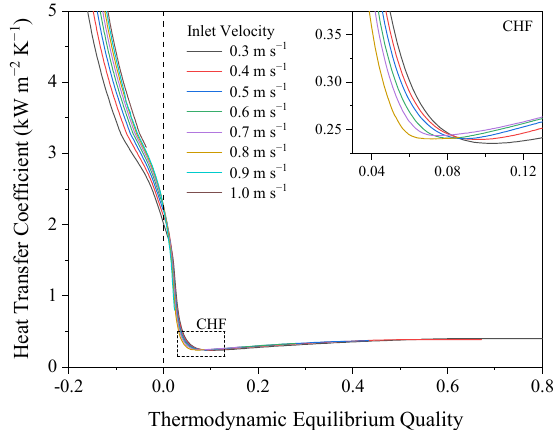
Figure 19. Heat transfer coefficient vs. thermodynamic equilibrium quality at inlet velocities of 0.3 m·s − 1 to 1.0 m·s − 1.